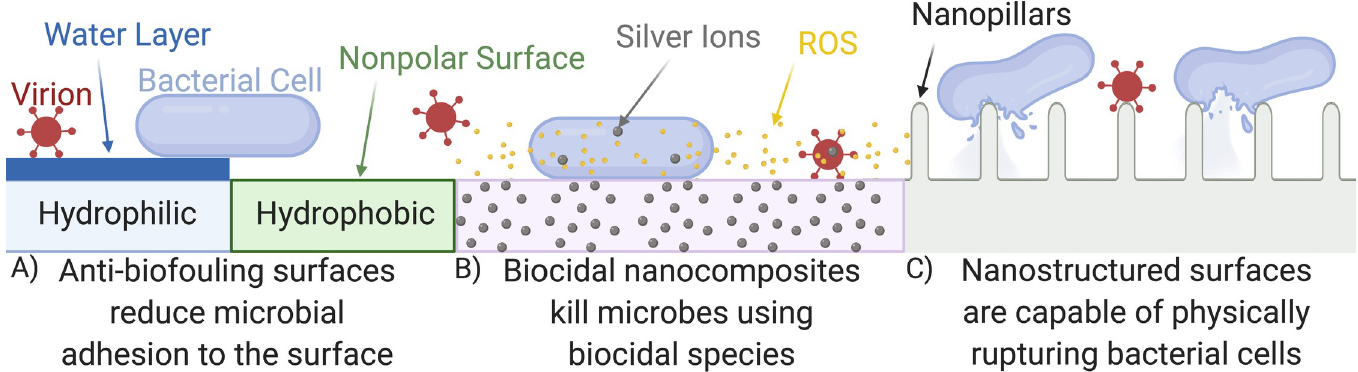
Fig 1. Antimicrobial surfaces operate through a number of mechanisms. (A) Anti-biofouling surfaces use specific surface energies to stop microbial adhesion by deterring adsorption to the surface or by forming a protective layer [36]. (B) Biocidal nanocomposites release incorporated biocidal species or act as a catalyst to produce biocidal species [32,37].(C) Nanostructured surfaces are capable of physically rupturing bacterial cells; however, further research is required to understand the impact of nanostructured surfaces on virions [35]. ROS, reactive oxygen species.